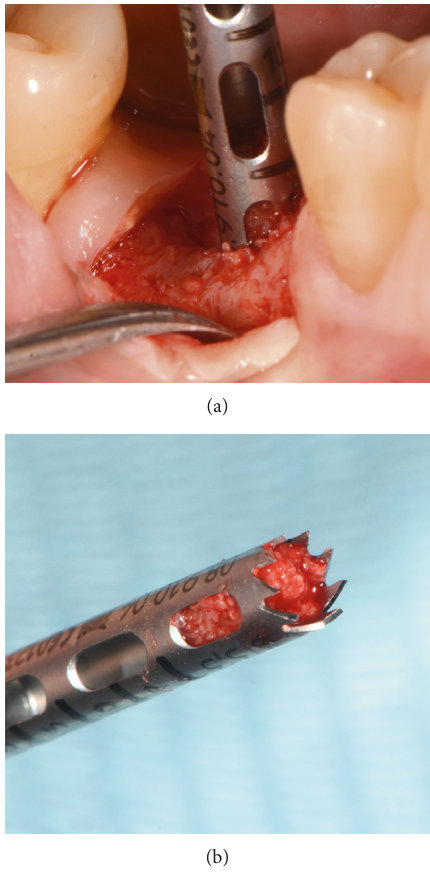
Figure 7: Trephine bone biopsy taken at the center of the regenerated site.